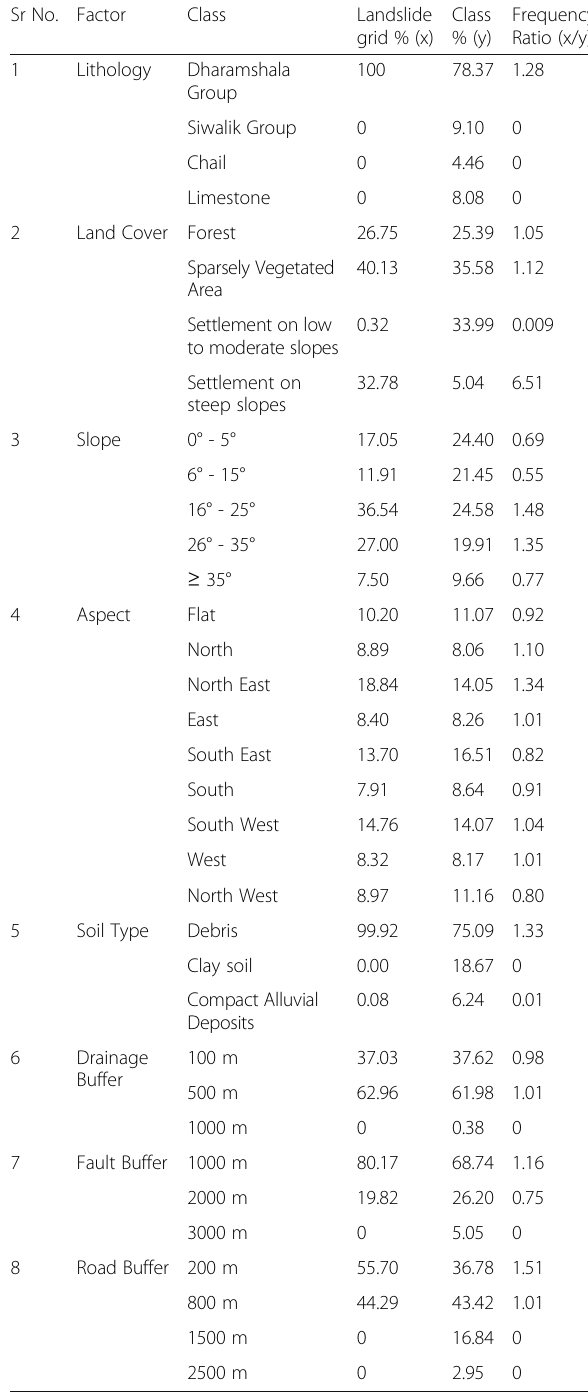
Table 5 Frequency ratio values for the factor classes Sr No.